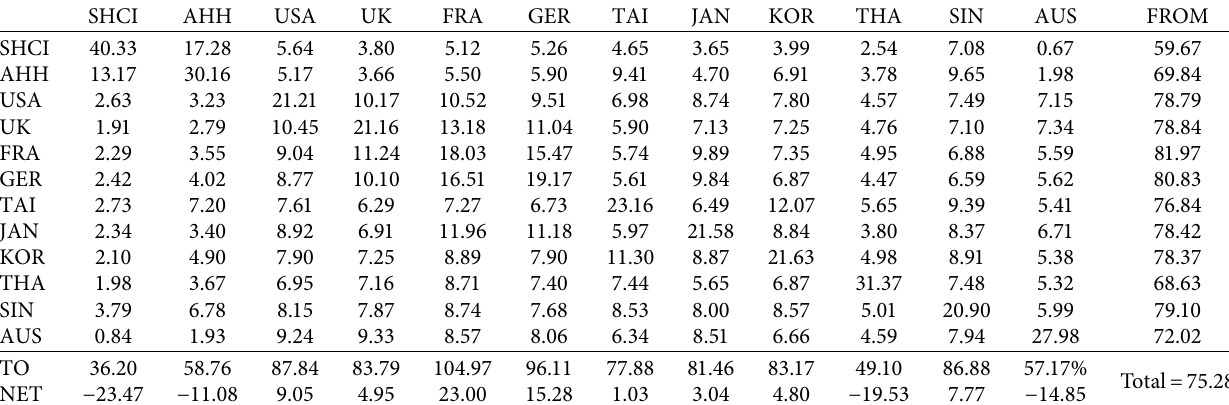
Table 6: Return spillover table of SHCI with other stock markets in the postperiod. SHCI